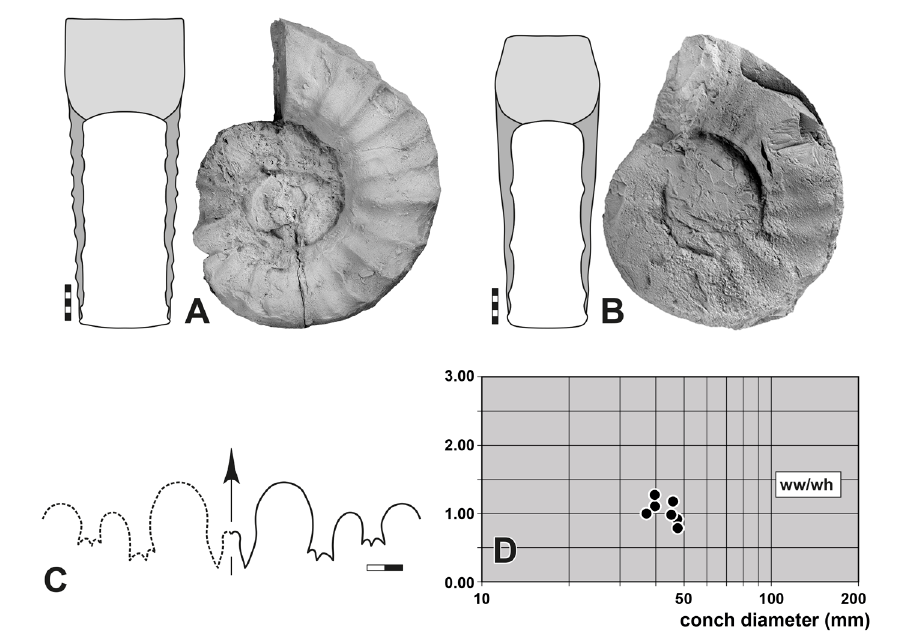
Fig. 56. Abichites abichi Shevyrev, 1965. A . Lateral and dorsal view, specimen MB.C.30039, section H, -1.30 m. B . Lateral and dorsal view, specimen MB.C.30019, section 1, -0.90 m. C . Suture line, specimen MB.C.30019, at 7.7 mm wh. D . Whorl profile proportions. Abbreviation: see Material and methods. Scale bar units = 1